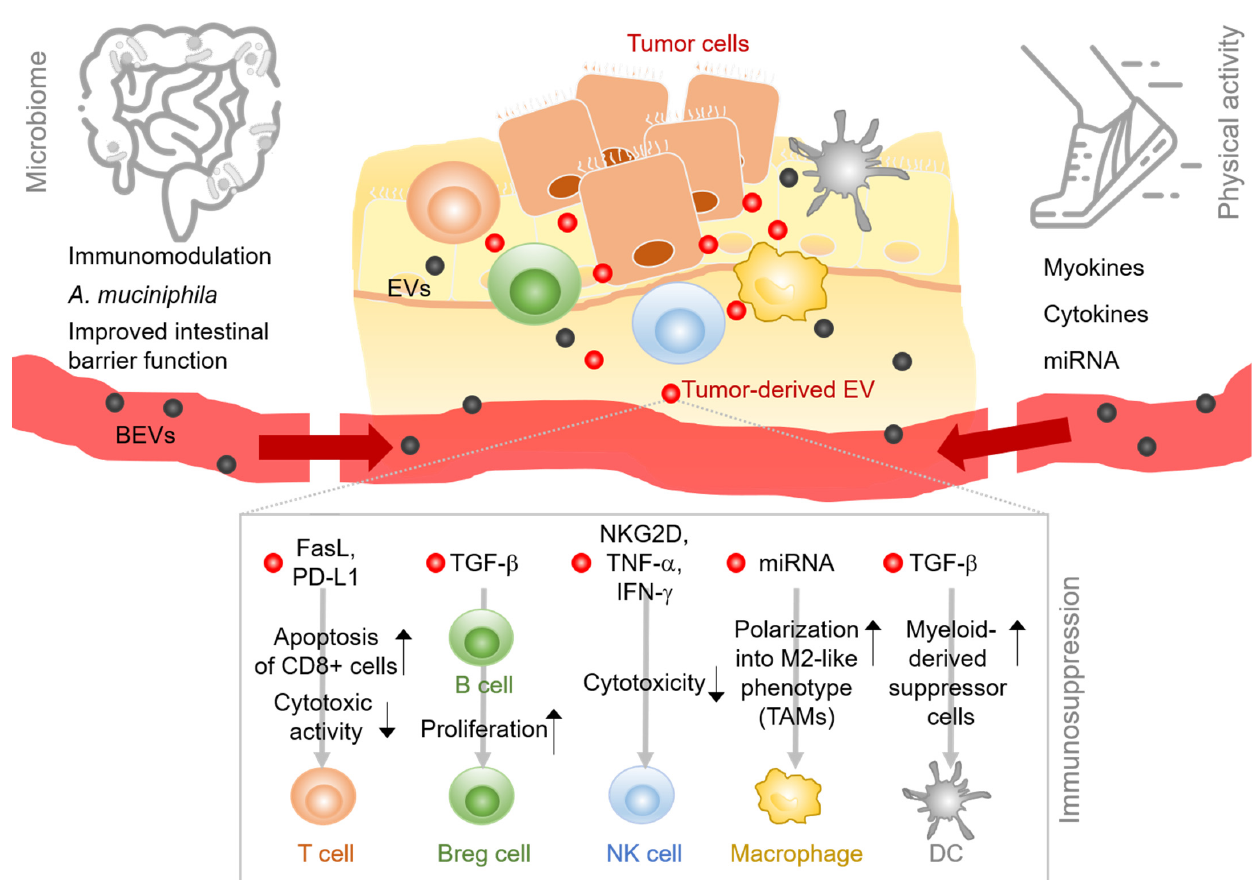
Figure 1. Extracellular vesicles (EVs) expand the tumor–immune interactions. In the local tumor microenvironment, EVs mediate intercellular communication between immune cells and tumor cells. Tumor-derived EVs suppress immune cell functions via several mediators and mechanisms. EVs derived from remote sources have the potential to shape the tumor–immune interactions in the tumor microenvironment directly or indirectly by either bacterial EVs (BEVs), derived from the host microbiome (left side) or by factors released during physical activity (right). Abbreviations: BEVs, bacterial extracellular vesicles; EVs, extracellular vesicles; FasL, fas ligand; PD-L1, programmed death-ligand 1; TGF- β , transforming growth factor beta; Breg cell, regulatory B cell; NKG2D, natural killer group 2D; TNF- α , tumor necrosis factor alpha; IFN- γ , interferon gamma; NK cell, natural killer cell; TAM, tumor-associated macrophage; DC, dendritic cell.